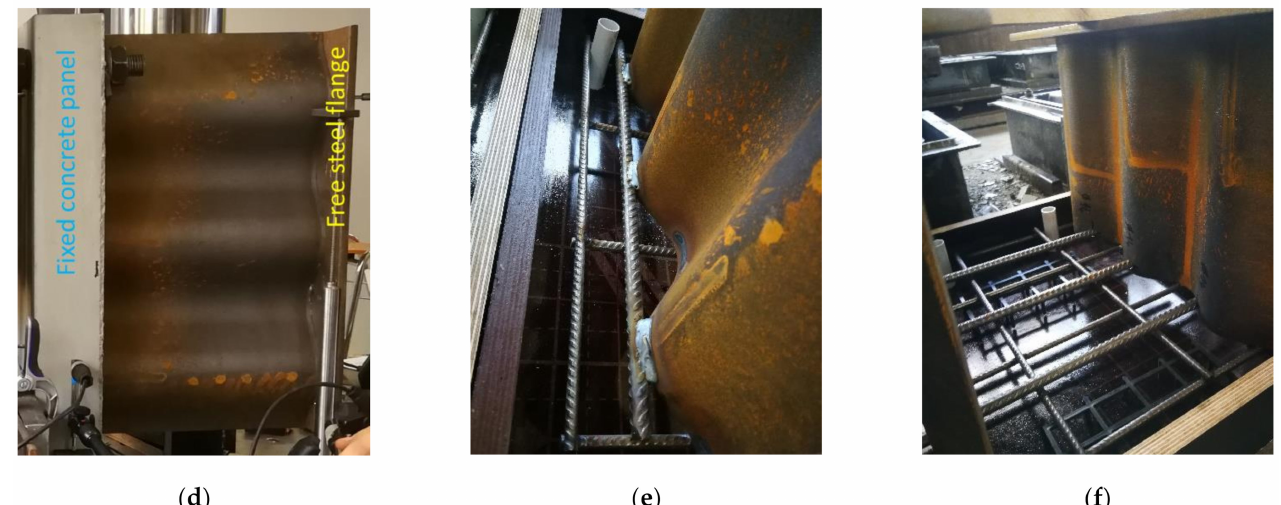
Figure 3. Test specimens: ( a ) Double wall with steel connectors; ( b ) Double wall with lattice girders, Ø5 mm diagonals; ( c ) Double wall element with lattice girders, Ø9 mm diagonals; ( d ) Thin-walled concrete panel with corrugated web SIN-T-beam; ( e ) welded bars in longitudinal direction for steel-concrete connection ( f ) transverse bars penetrating the beam for steel-concrete